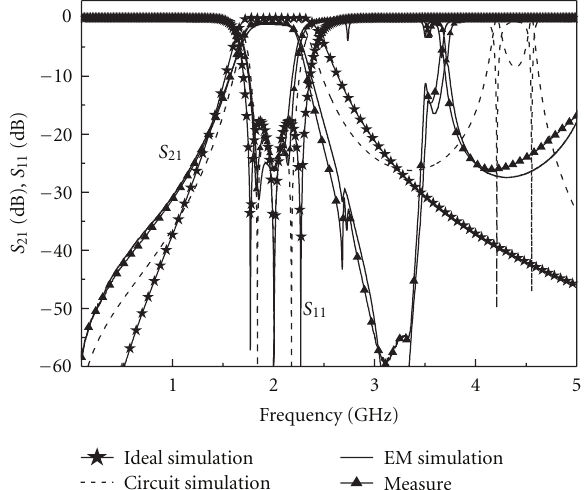
Figure 7: Frequency response of the filter of Figure